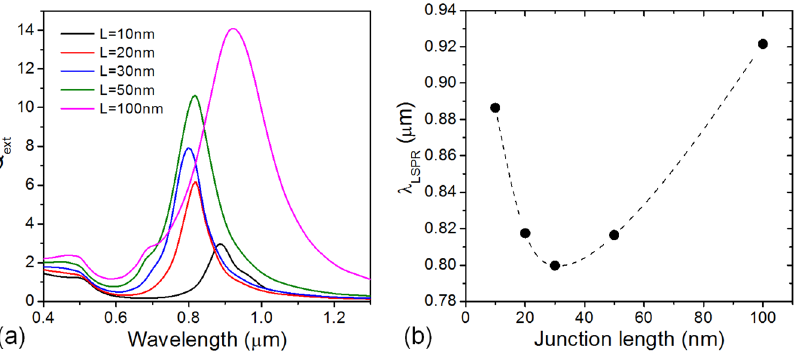
Figure 5. Effect of VCB length change on the ( a ) total extinction efficiency spectra and ( b ) their resonance